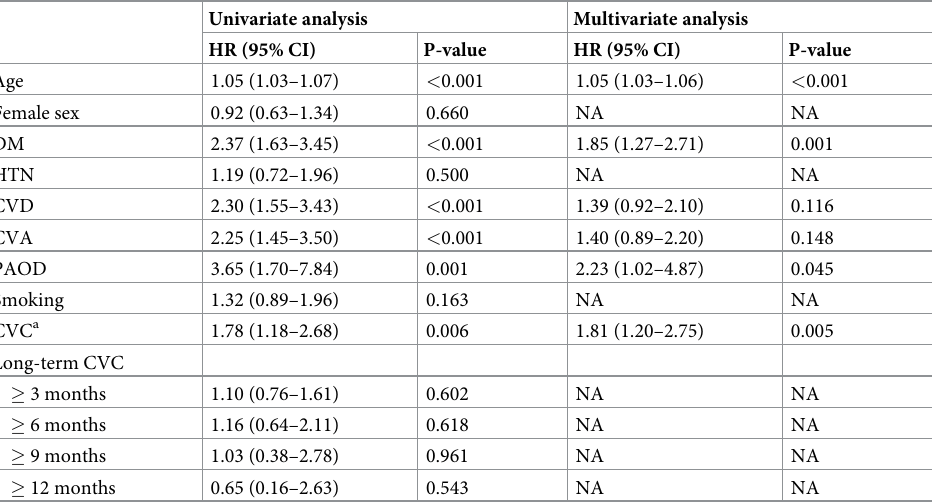
Table 4. Factors associated with mortality in the study population.